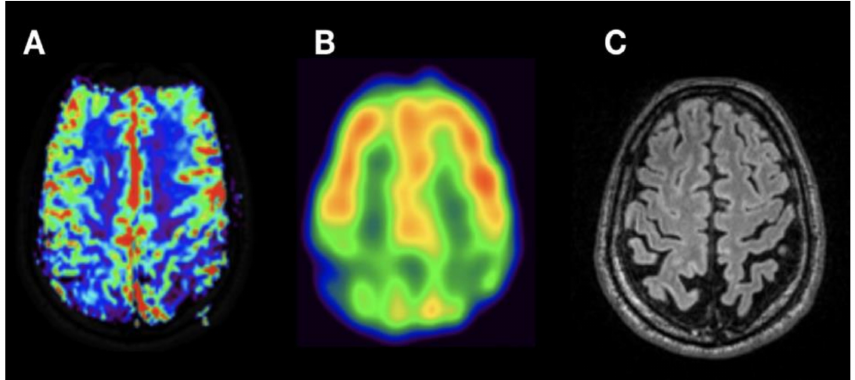
Figure 5. Male with DLB, 60 y, Mini-Mental-Status-Test score 30. DSC Perfusion ( A , axial orientation rCBVc) shows typical pattern of parieto-occipital cortical hypoperfusion. Correlation with HMPAO-SPECT ( B ) and the anatomical dataset with widening of the parieto-occipital subarachnoid spaces as sign of atrophy ( C , T2